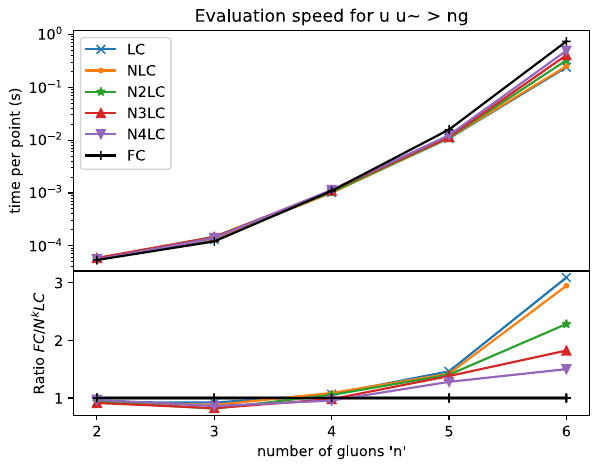
Fig. 11 Same as Fig. 10 but for u ¯ u →